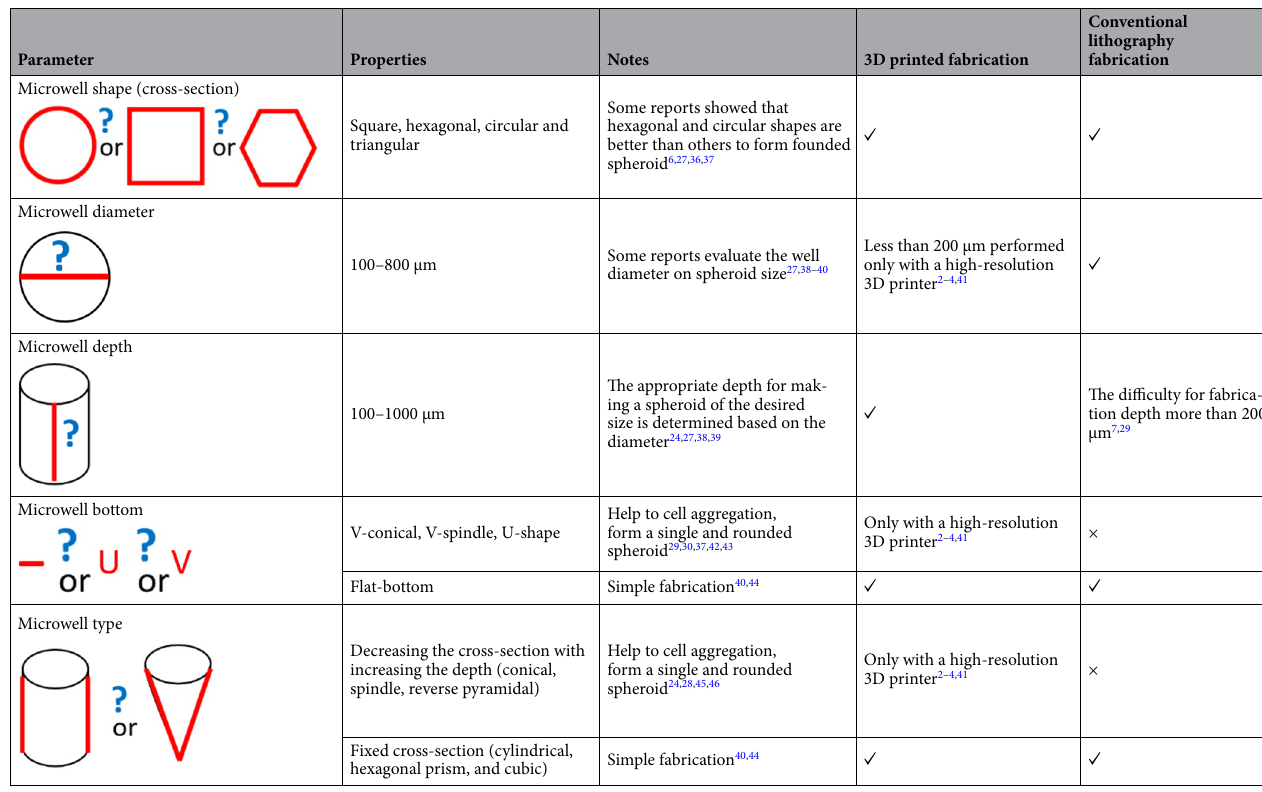
Table 1. Important parameters of microwells that are effective in the spheroid